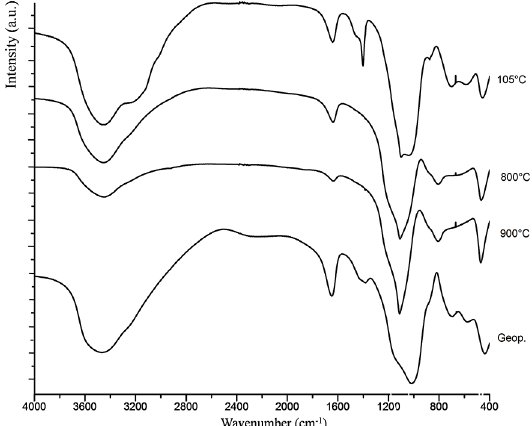
Figure 4. FTIR spectra of powders heat treated at 105 °C, 800 °C, 900 °C and